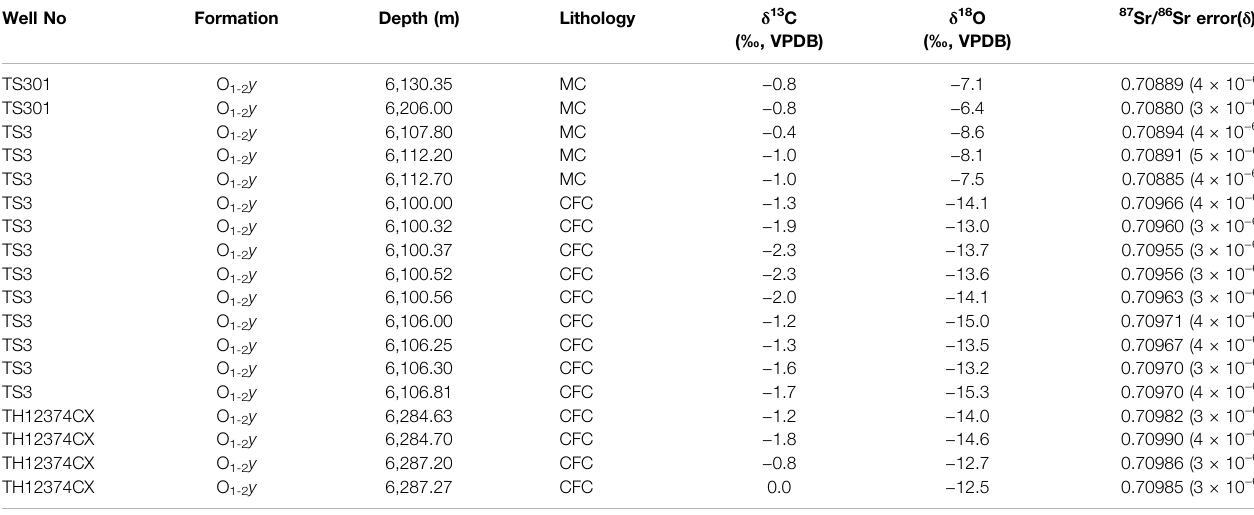
TABLE 2 | The isotopic compositions of micrite limestone and CFC in the coverage area.